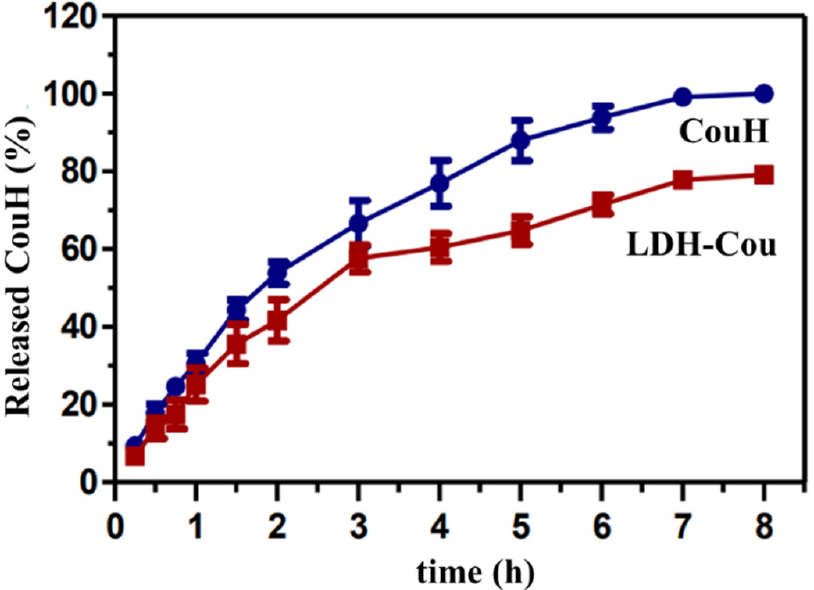
Figure 2. Release profile of CouH and LDH-Cou. Data are presented as percentage of released compound through time, mean ± SD ( n = 5).